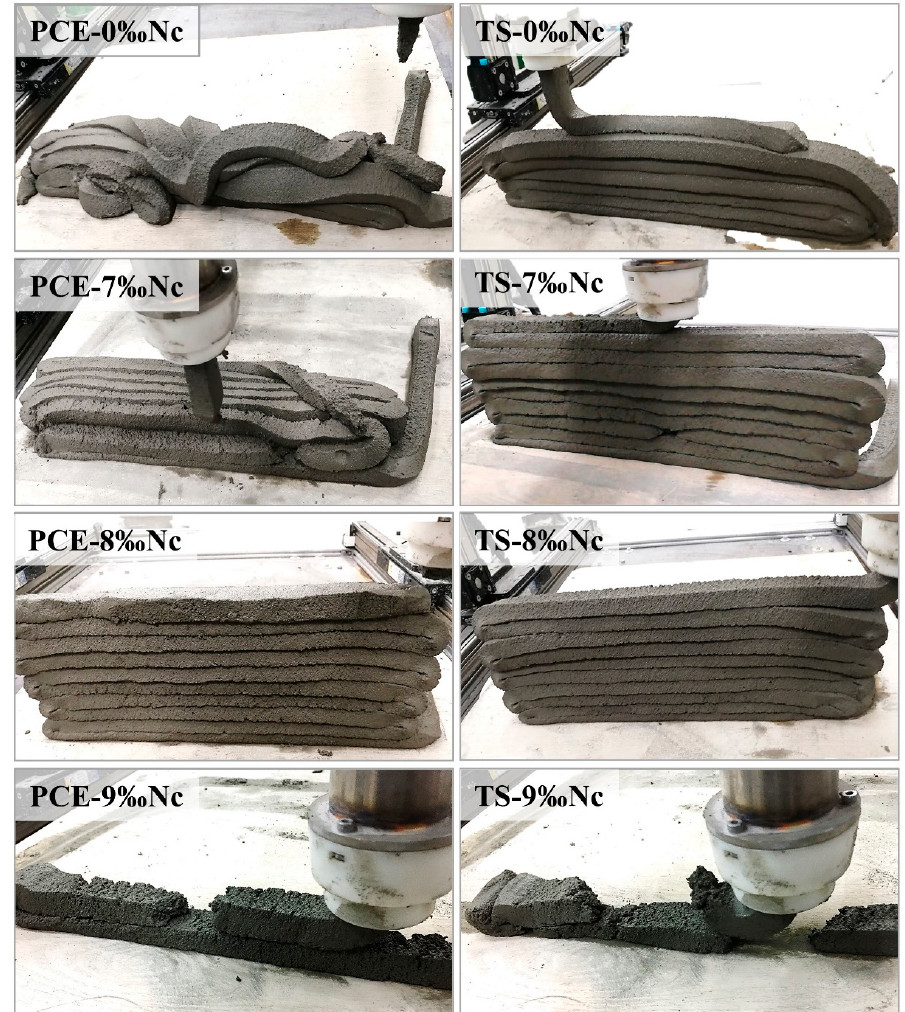
Figure 4. Demonstration of 3D printability of cement paste with different type of superplasticizers and different dosage of nano clay. Materials 2021 , 14 , x FOR PEER REVIEW